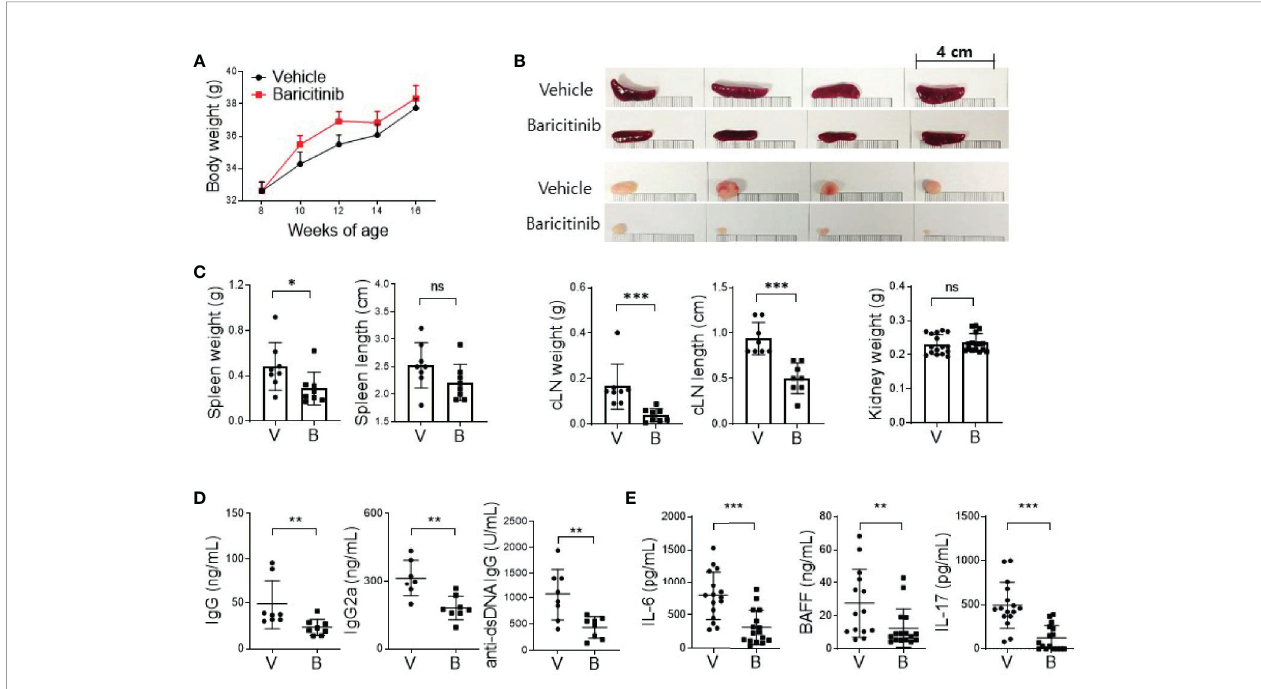
FIGURE 1 | In vivo treatment with baricitinib abrogates lupus-like phenotype of MRL/ lpr mice. Eight-week-old MRL/ lpr mice (n = 8 in each group) were treated by gavage with either vehicle (V) only or baricitinib (B, 10 mg/kg) twice daily for eight weeks. Mice were euthanized at the age of 16 weeks. (A) Body weights of